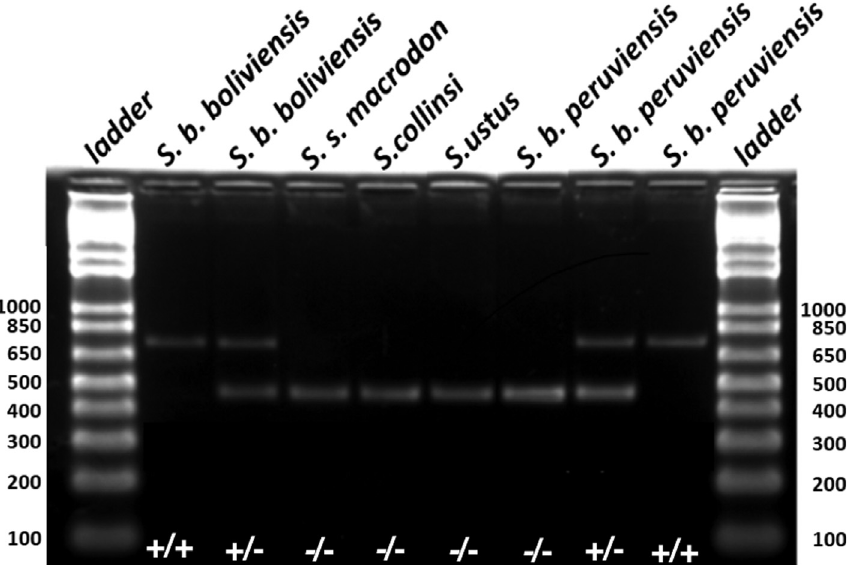
Figure 2 - Electrophoresis gel showing the distribution of the three Alu genotypes (+/+; +/-; and -/-) in the five subspecies sampled in the present study. A 1 kb ladder placed at both sides of the gel indicates the size in base pairs (bp) of the two amplified